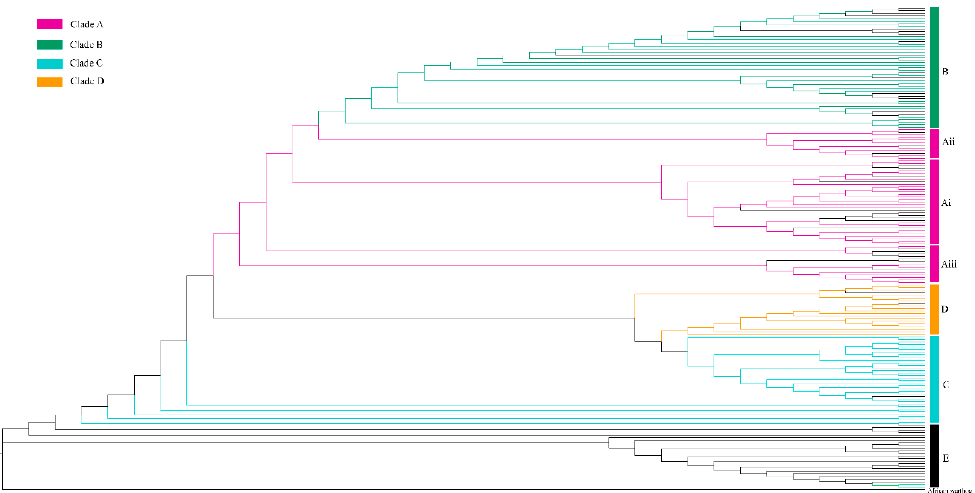
Figure 3. Phylogenetic tree of Chinese native pigs constructed with 124 haplotypes and 60 reference sequences by the maximum likelihood method, with the African warthog (DQ409327.1) as the outgroup. Different clades are represented by different colors. Clade A is clustered into 3 groups (Ai, Aii, and Aiii). Clades B, C, and D each cluster into one group. E represents European wild boars and domestic pigs.